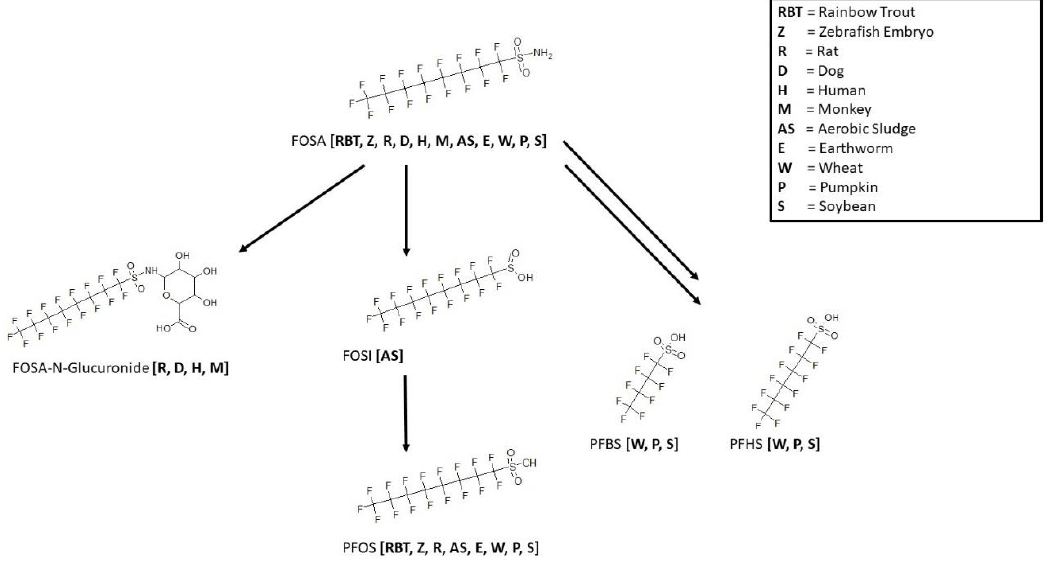
Figure 11. Metabolic map for Perfluorooctanesulfonamide (FOSA) as found in rainbow trout [39], rat [25,40], dog [40], human [40], monkey [40], aerobic sludge [32], earthworm [41,42], pumpkin [43], soybean [43], wheat [41], and zebrafish embryo [30].